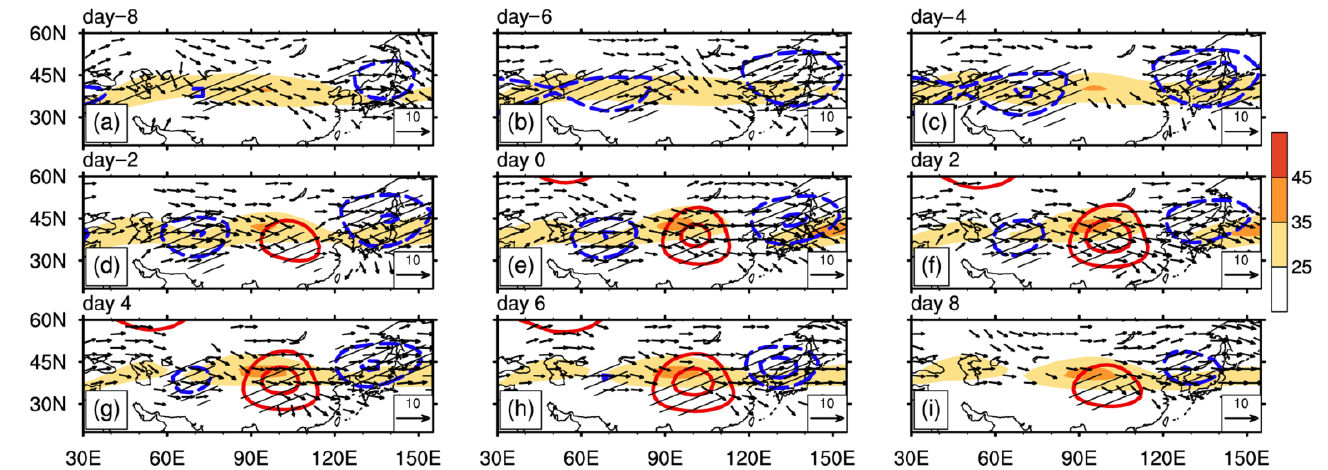
Figure 4. The same as in Figure 3, but for the SRP− events in Table 2.